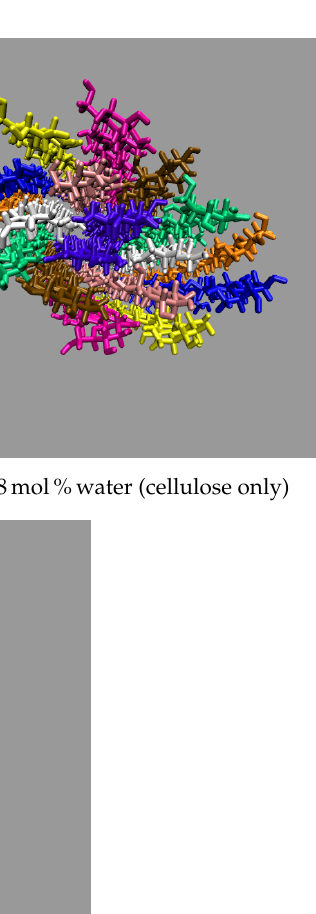
Figure A7. End view images of the cellulose bundle dissolution at 600ns, showing only the cellulose bundle (Part 1 of 2) at: ( a ) 63.1mol%water; ( b ) 79.4mol%water; ( c ) 86.8mol%water; and ( d ) 91.1mol%water.